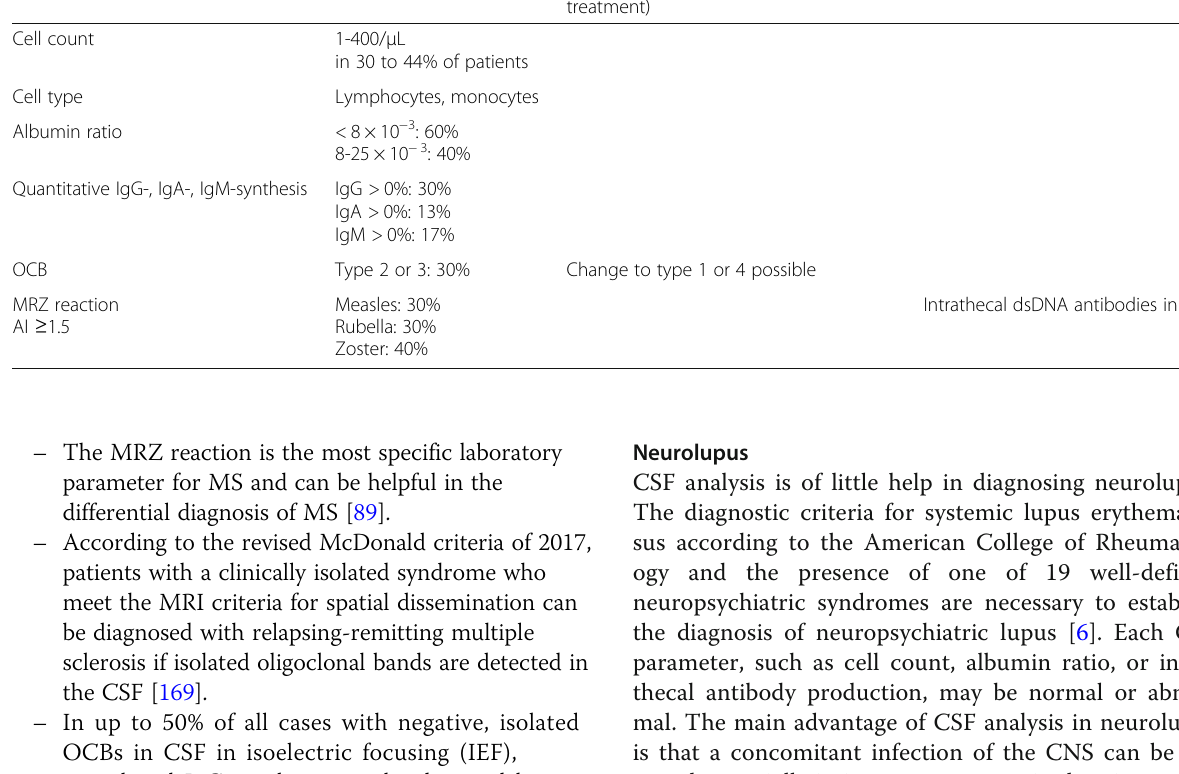
Table 13 Summary of relevant CSF findings in neuropsychiatric lupus Parameter